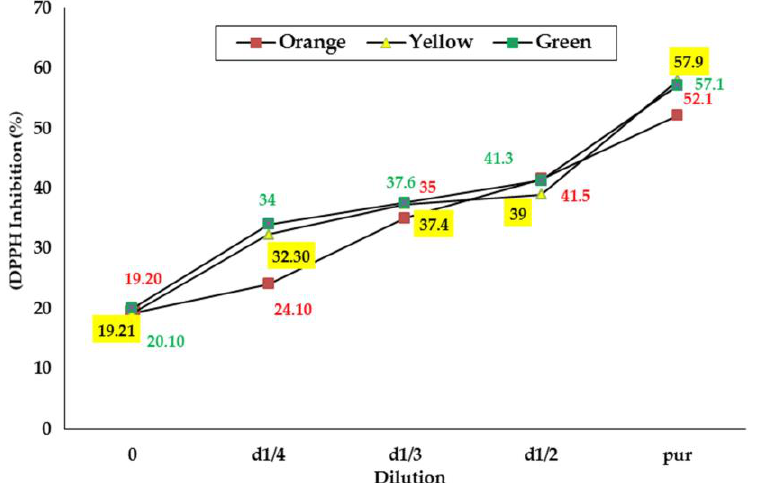
Figure 2 Percentage of inhibition of the DPPH radical calculated for the seed extracts from the three cultivars of prickly